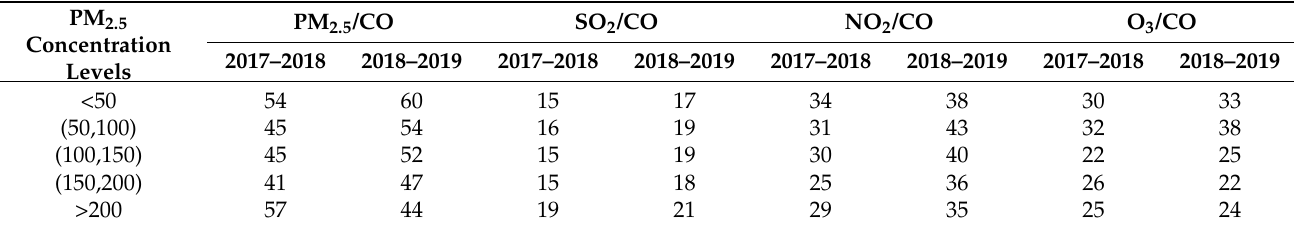
Table 2. The concentration ratio of PM 2.5 /CO, SO 2 /CO, NO 2 /CO, and O 3